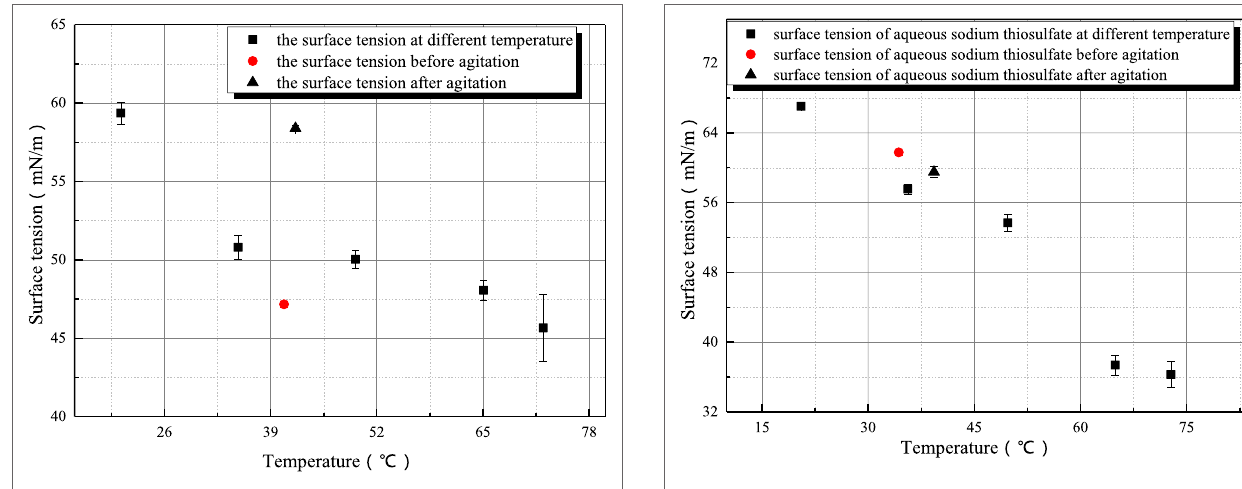
FigUre 9 | The influence of agitation on the surface tension of sodium thiosulfate (sodium hydroxide concentration is 1 mol/L).